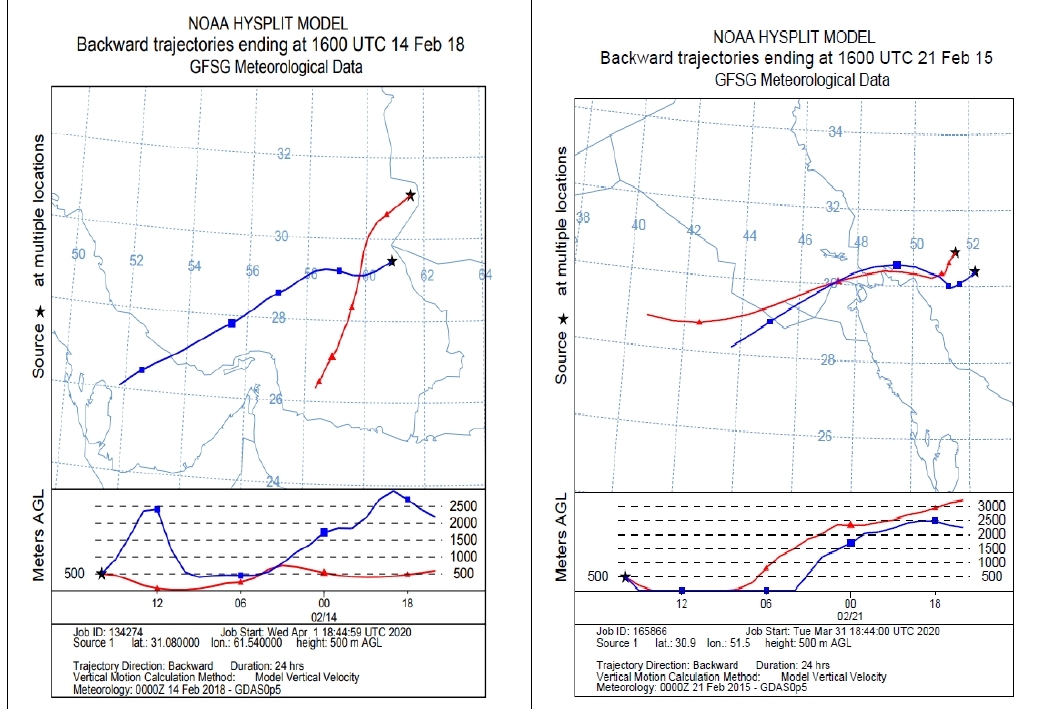
Figure 5. Backward trajectories of dust from the National Oceanic and Atmospheric Administration Hybrid Single Particle Lagrangian Integrated Trajectory (NOAA HYSPLIT) Model.